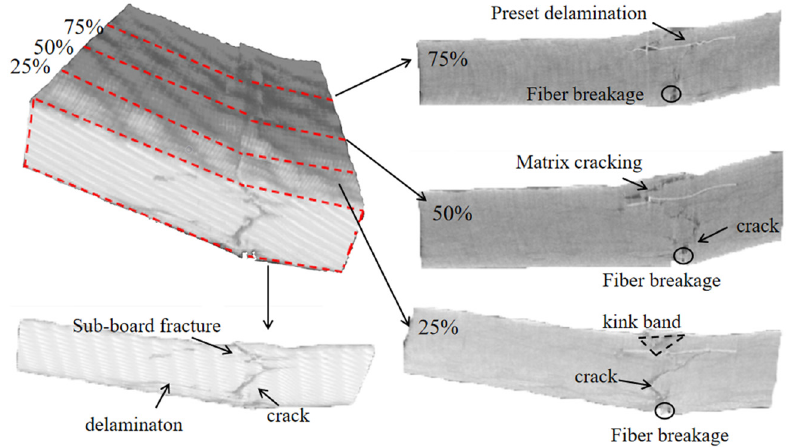
Figure 13: Micro - CT images of failure modes of specimen C at 25, 50, and 75% cross sections in the width direction.